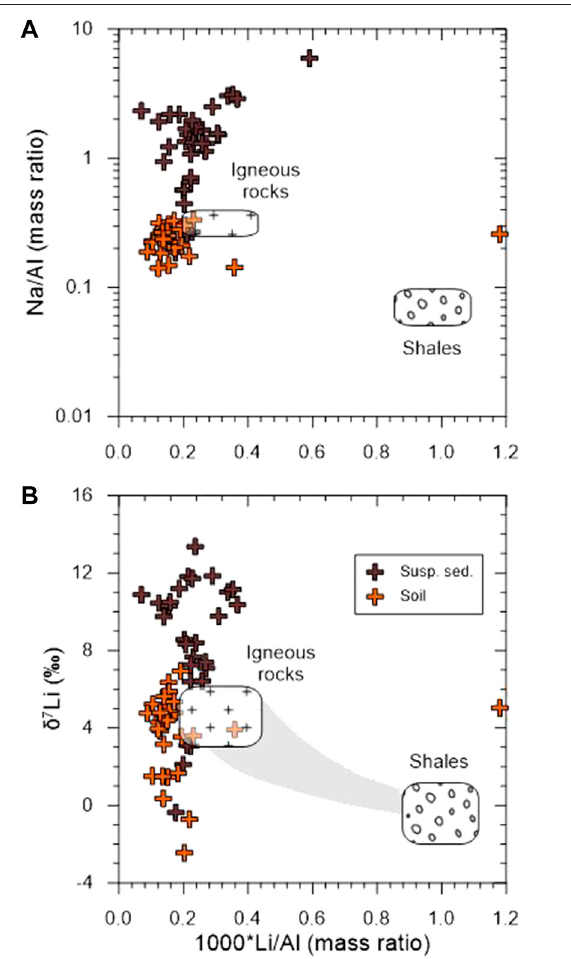
FIGURE6| PlotsofNa/Al(massratio) (A) and δ 7 Li (B) versusLi/Al(mass ratio)in thesuspended sedimentand soil samples.Bedrock endmembers are from Dellinger et al.